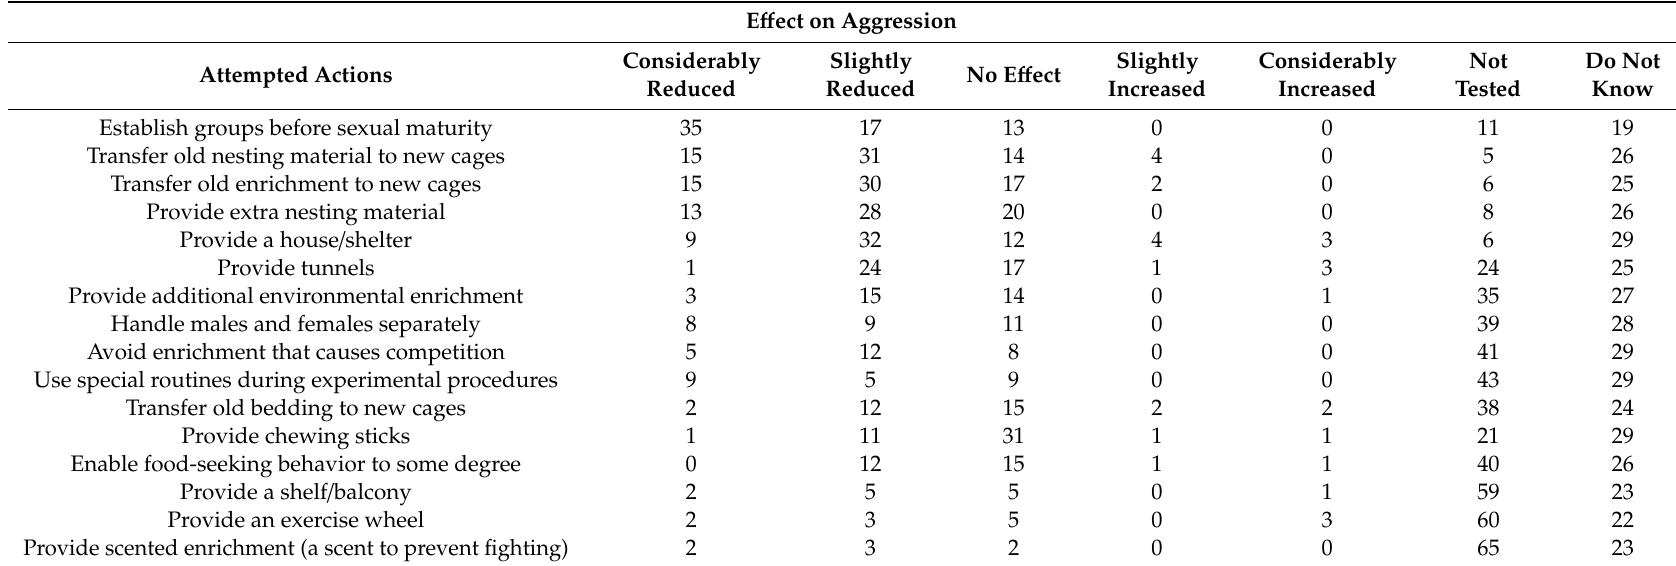
Table 1. Attempted actions to facilitate group housing of male mice. Given is the number of answers within each